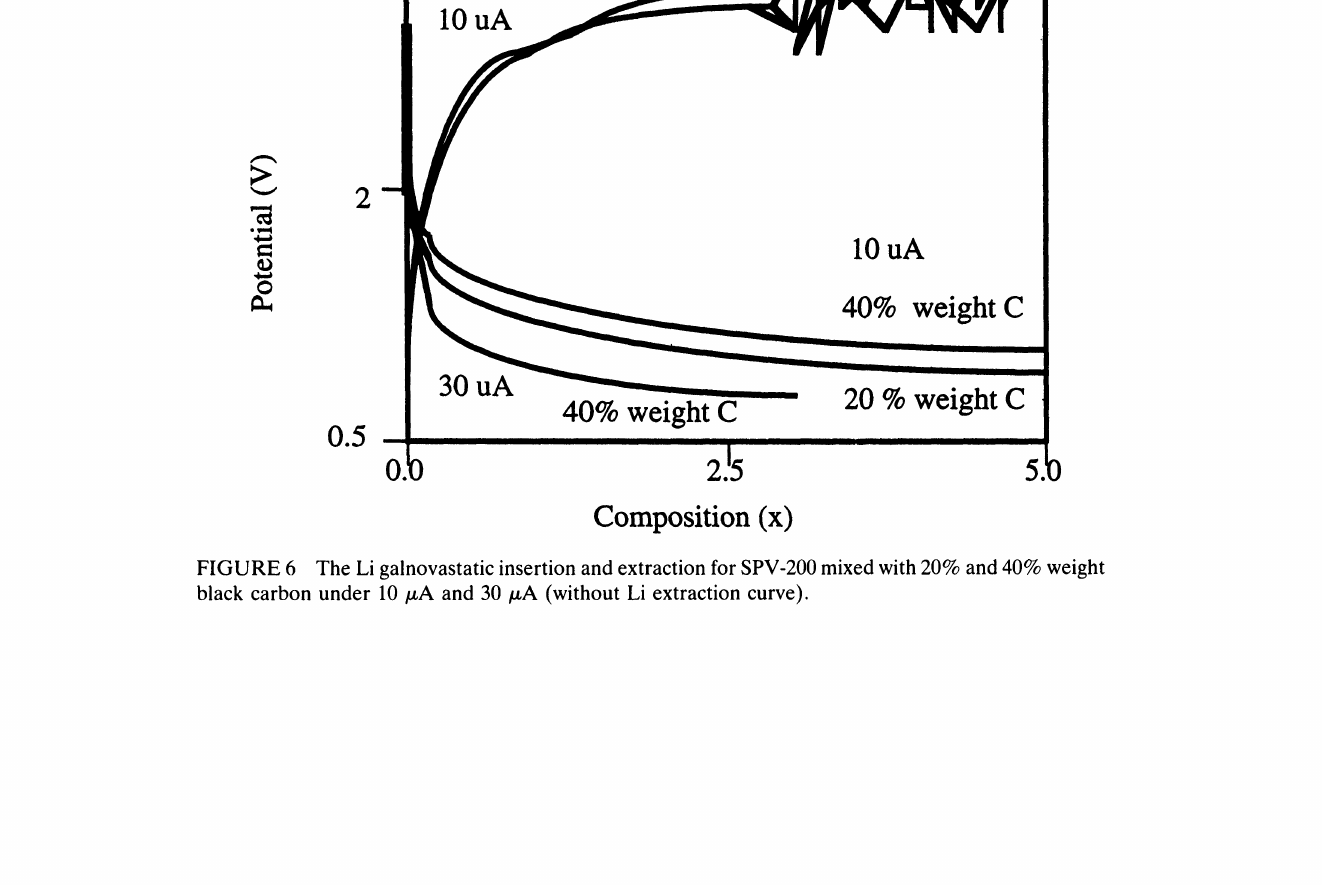
FIGURE 5 Potential vs. composition for Superlig under the different discharge current.